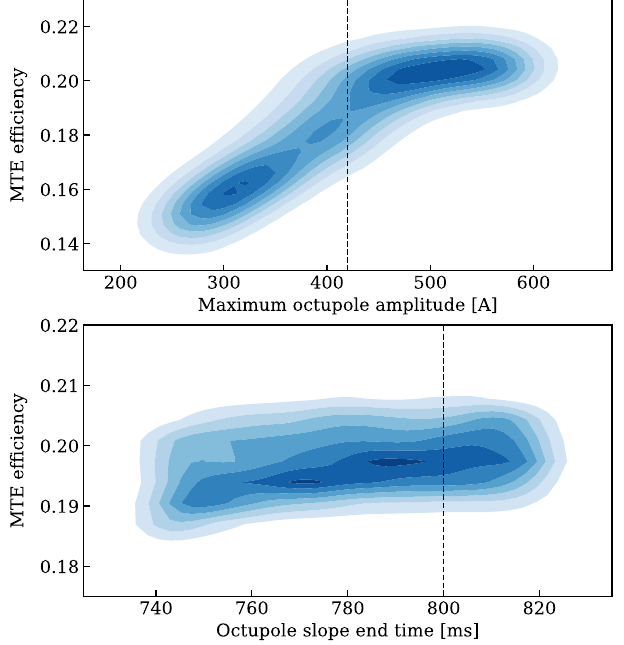
FIG. 3. Distribution of η as a function of the maximum MTE strength of octupoles ONO39 and ONO55 (upper) and of their slope (lower). A strong dependence of η on the strength is MTE visible, while the slope is affecting it only mildly. The vertical dashed lines represent the values of the operational settings.